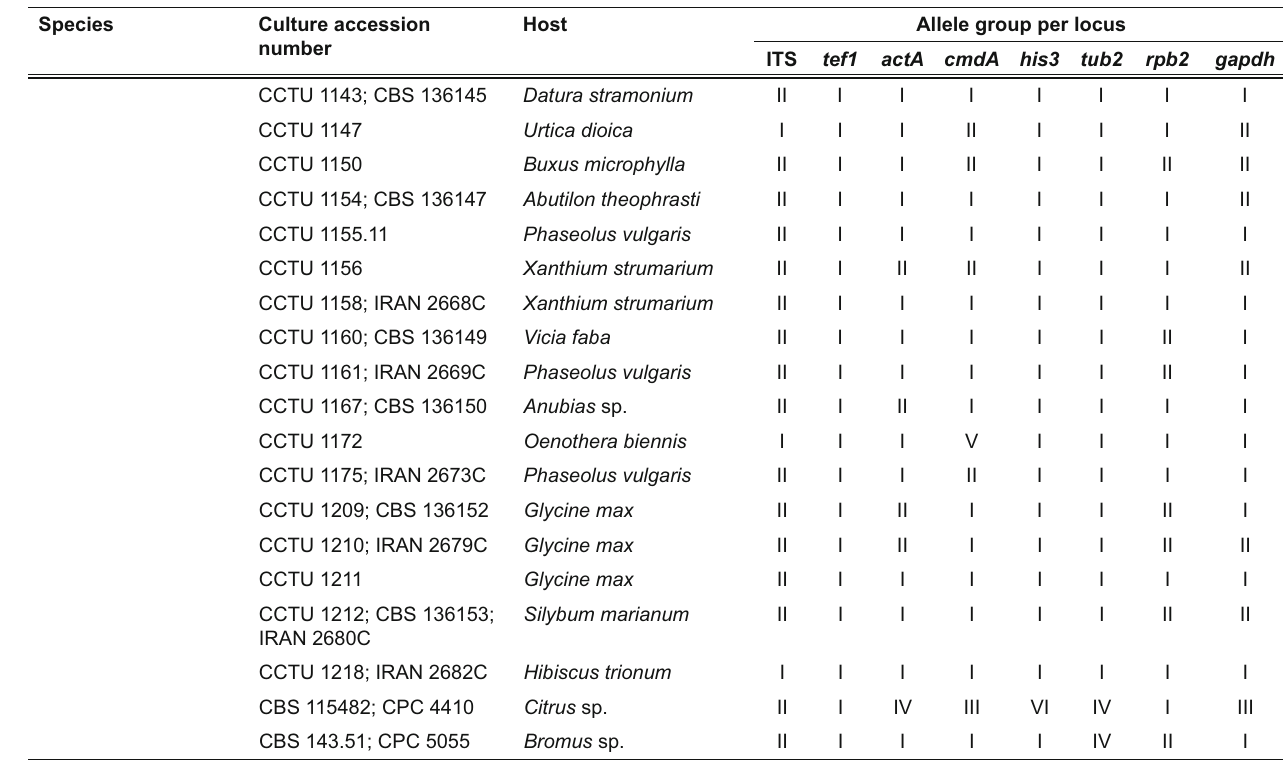
Table 8. (cid:24)%(cid:4)(cid:17)(cid:8)(cid:11)(cid:17)(cid:5)(cid:13)(cid:21)(cid:27)(cid:28) Species Culture accession